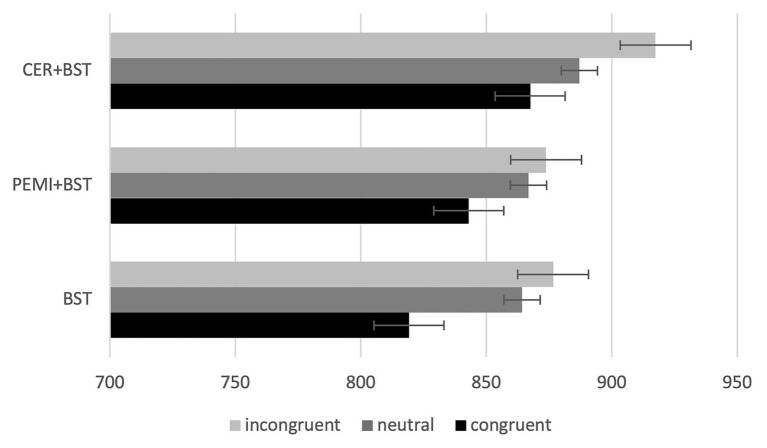
Mean response time and standard error (bars) by sessions and trials. BST, bivalent shape task; CER, control exercise recovery; PEMI, post-exercise muscle ischemia.